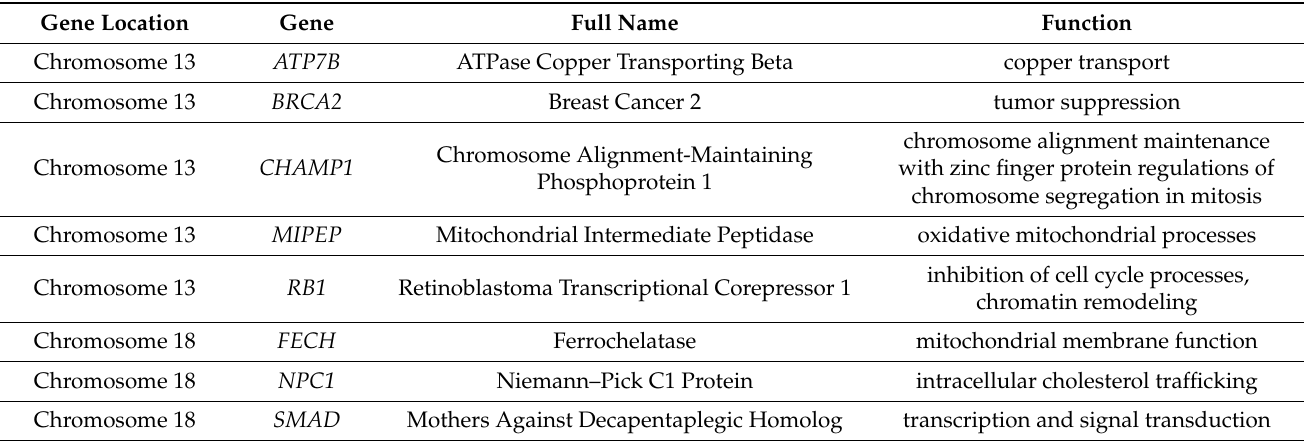
Table 2. Gene expression related to T13 and T18